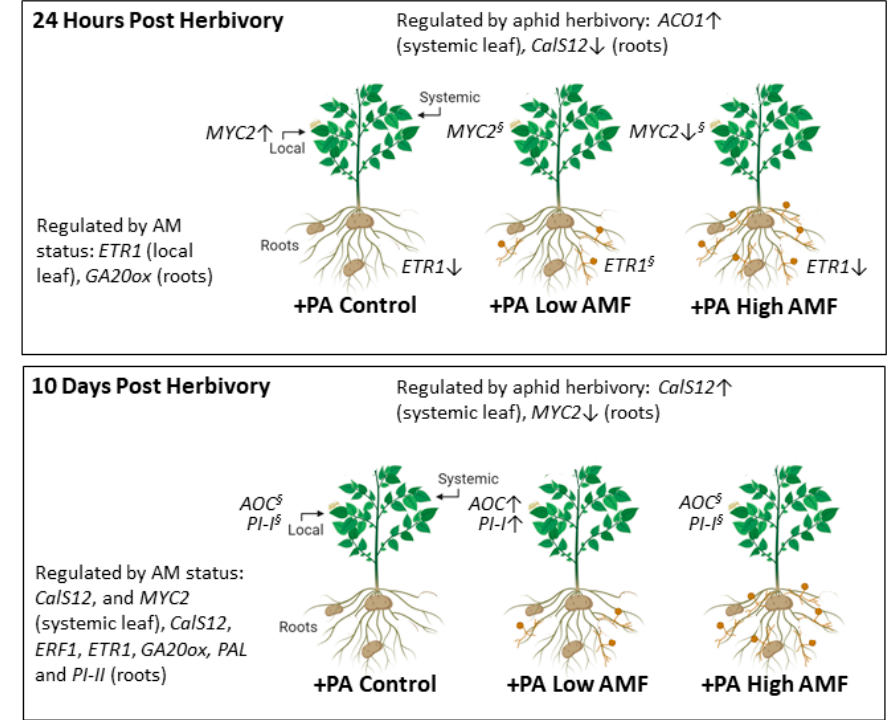
Figure 8. Summary of the e ff ect of low and high level of AM fungal root colonization, 24 h and 10 days post-herbivory by potato aphids ( Macrosiphum euphorbiae ) on potato plants ( Solanum tuberosum ). For simplicity, only aphid-infested treatments such as potato-aphid-infested non-mycorrhizal plants ( + PA Control), potato-aphid-infested plants with a low level of AM fungal root colonization ( + PA Low AMF), and potato-aphid-infested plants with a high level of AM fungal root colonization ( + PA High AMF) were included in this diagram. Changes in plant gene expression were mediated by aphid herbivory, AM status, ortheinteractionbetweenpotatoaphidherbivoryandAMfungalrootcolonization. Upregulation ( ↑ ) or downregulation ( ↓ ) of gene expression in local leaves, systemic leaves, and roots are shown. § Gene expression level was not statistically di ff erent from the level in non-infested non-mycorrhizal plants ( − PA Control). ACO1 = AMINOCYCLOPROPANE-1-CARBOXYLATE OXIDASE 1; AOC = ALLENE OXIDE CYCLASE; CalS12 = CALLOSE SYNTHASE 12; ERF1 = ETHYLENE RESPONSE FACTOR 1; ETR1 = ETHYLENE RECEPTOR 1; GA20ox = GIBBERELIC ACID 20-OXIDASE; MYC2 = BASIC- HELIX-LOOP-HELIX TRANSCRIPTION FACTOR; PAL = PHENYLALANINE AMMONIA LYASE; PI-I = POTATO TYPE I PROTEASE INHIBITOR; PI-II = POTATO TYPE II PROTEASE INHIBITOR . Data from Figures 2–7 were used to create this diagram with